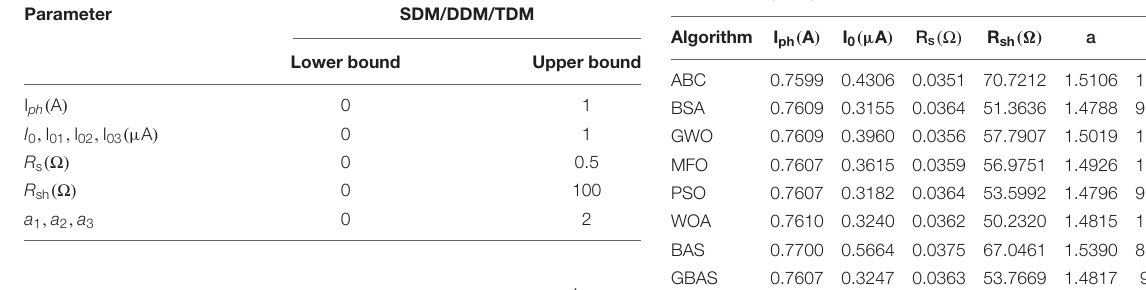
TABLE 5 | Parameters bounds of different photovoltaic (PV) cell models. TABLE 7 | Model parameters identified by various algorithms for single diode model (SDM).